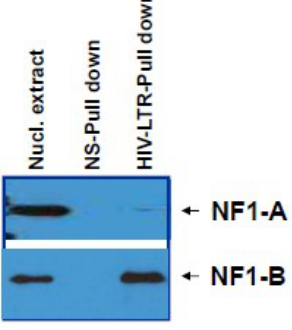
Figure 2. Specificity of NF-IB to HIV-1 LTR. HIV-1-infected Jurkat cells were harvested on day 5 post-infection. Nuclear extracts were prepared as descried under materials and methods and used for the long terminal repeat (LTR) pull-down experiments. To check the specificity of the NF-IB association, both non-specific (biotinylated GAPDH DNA region coupled with streptavidin agarose), and LTR HIV-1 (biotinylated LTR DNA coupled with streptavidin agarose) were used for the pull-down experiments. The bound proteins, along with the control nuclear extracts, were detected using NF-IA or NF-IB